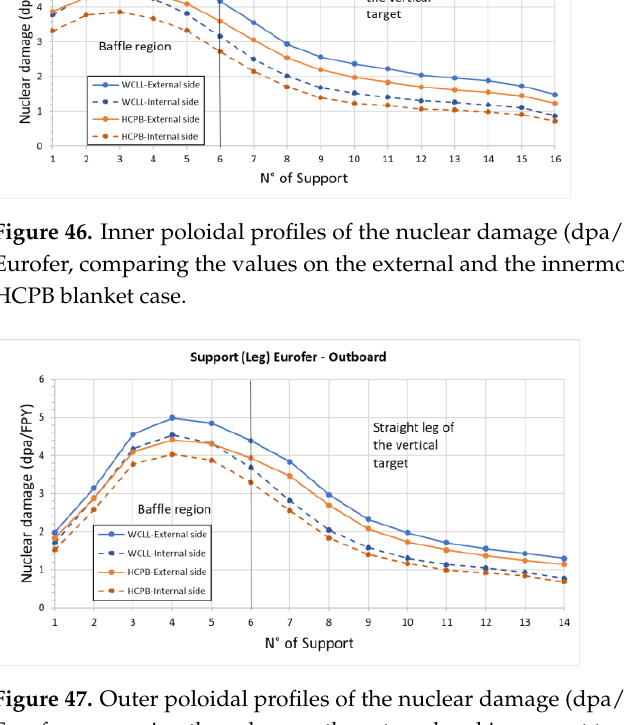
Figure 49. Outer poloidal profiles of the He-production (appm/FPY) on PFC-CB supports made of Eurofer, comparing the values on the external and innermost target sides, both for WCLL and HCPB blanket case. Looking at Figure 48, the variance between the profiles is around +5/10% for the sup- ports positioned on the inner baffle region (+6.2% comparing the corresponding peak val- ues shown in Tables 6 and 8), not varying the order of magnitude (+5/15%) on the straight leg of the inner vertical targets (+16.0% comparing the corresponding minimum values